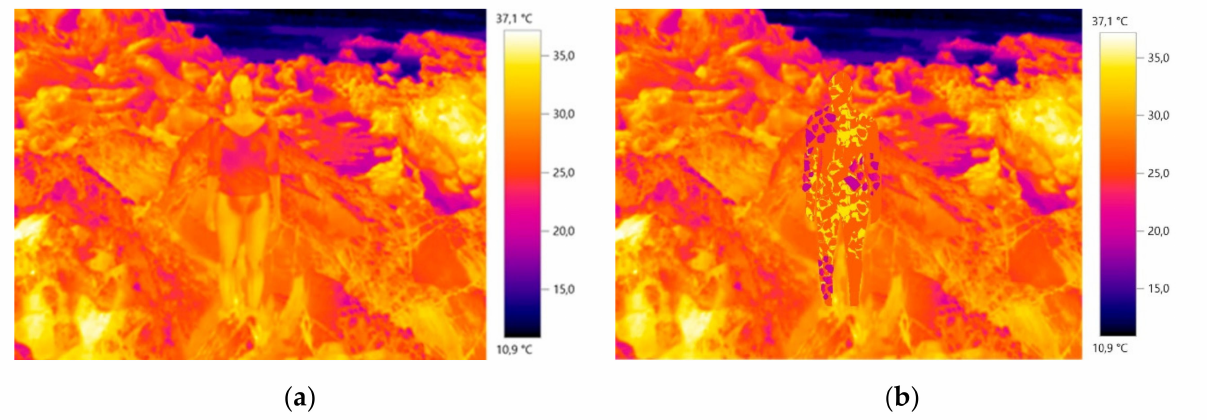
Figure 11. The diurnal thermal camouflage prototype conceptualized: ( a ) Base thermal image without the Design elaboration for the camouflage; ( b ) Base thermal image with the prototype illustration.